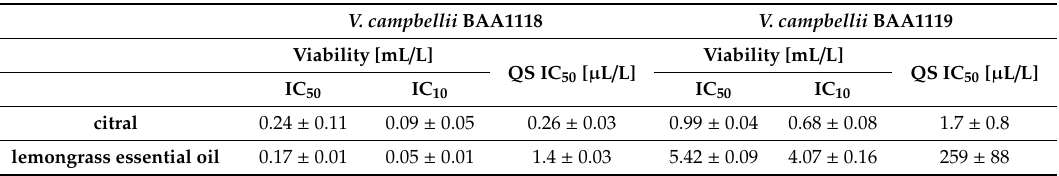
Table 4. The effect of citral and lemongrass essential oil on the quorum sensing and viability of Vibrio campbellii.